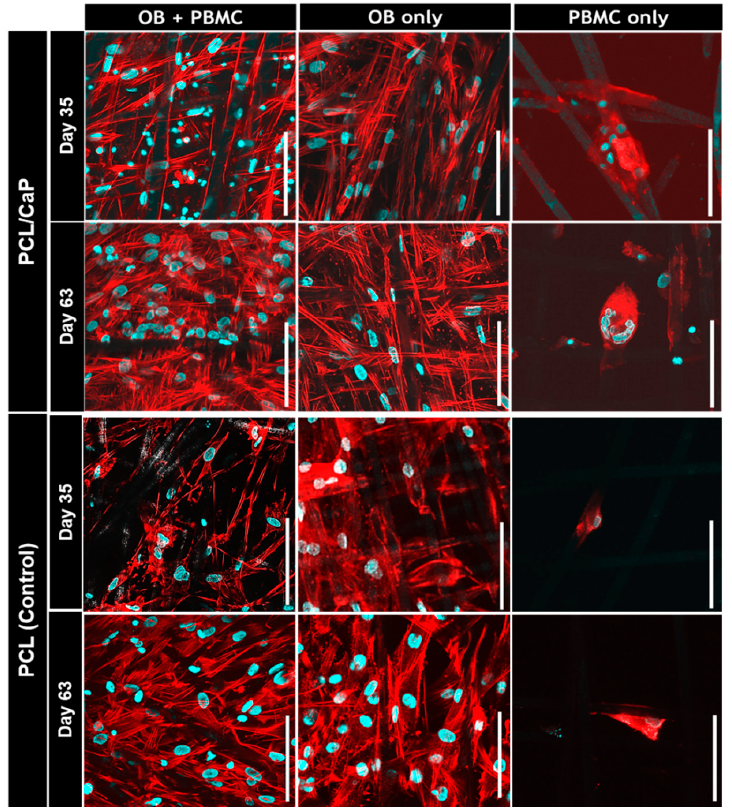
Figure 2. Cell-seeded polycaprolactone (PCL) with or without calcium phosphate (CaP) surface-coated scaffolds stained with Hoechst (blue—cell nuclei) and Phalloidin (red—actin filaments). OB = osteoblast; PBMC = peripheral blood mononuclear cell. Scale bar = 100 μ m.